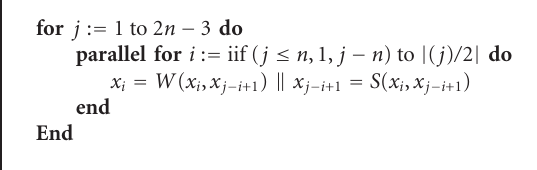
Algorithm 4: Reindexed algorithm for reduction tasks.